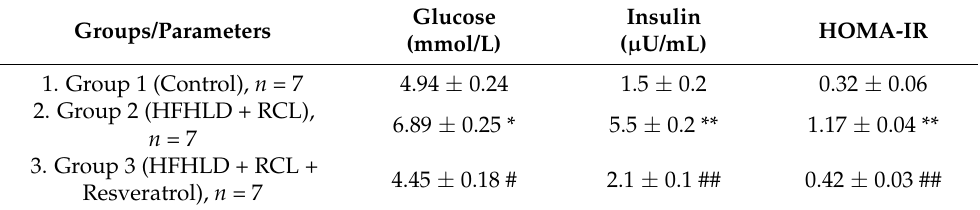
Table 4. Effects of resveratrol on carbohydrate metabolism in the serum of rats fed a high-fructose high-lipid diet (HFHLD) under round-the-clock lighting